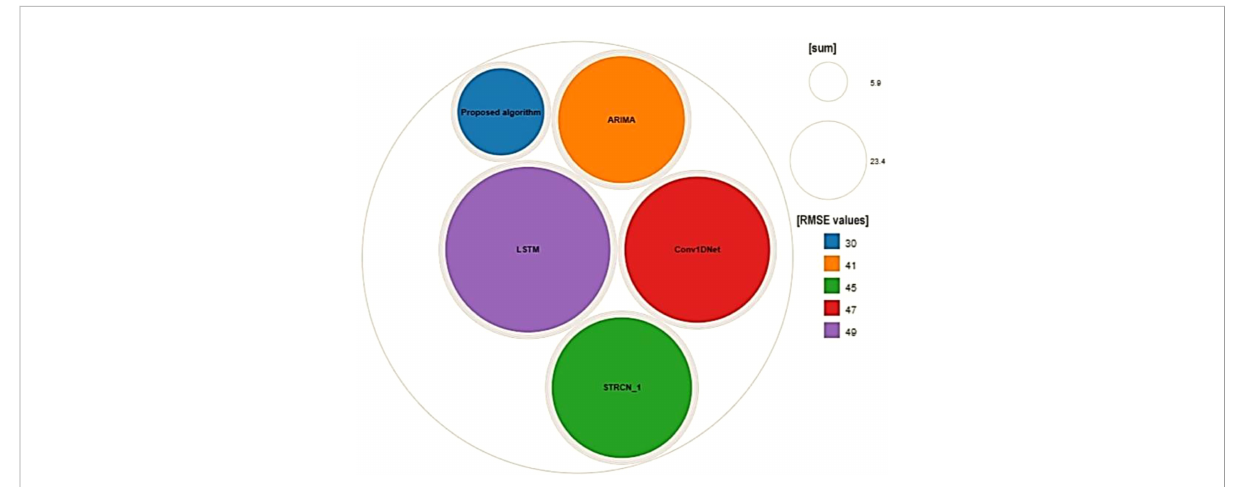
FIGURE 7 RMSE based results of the proposed model with the selected benchmark algorithms.